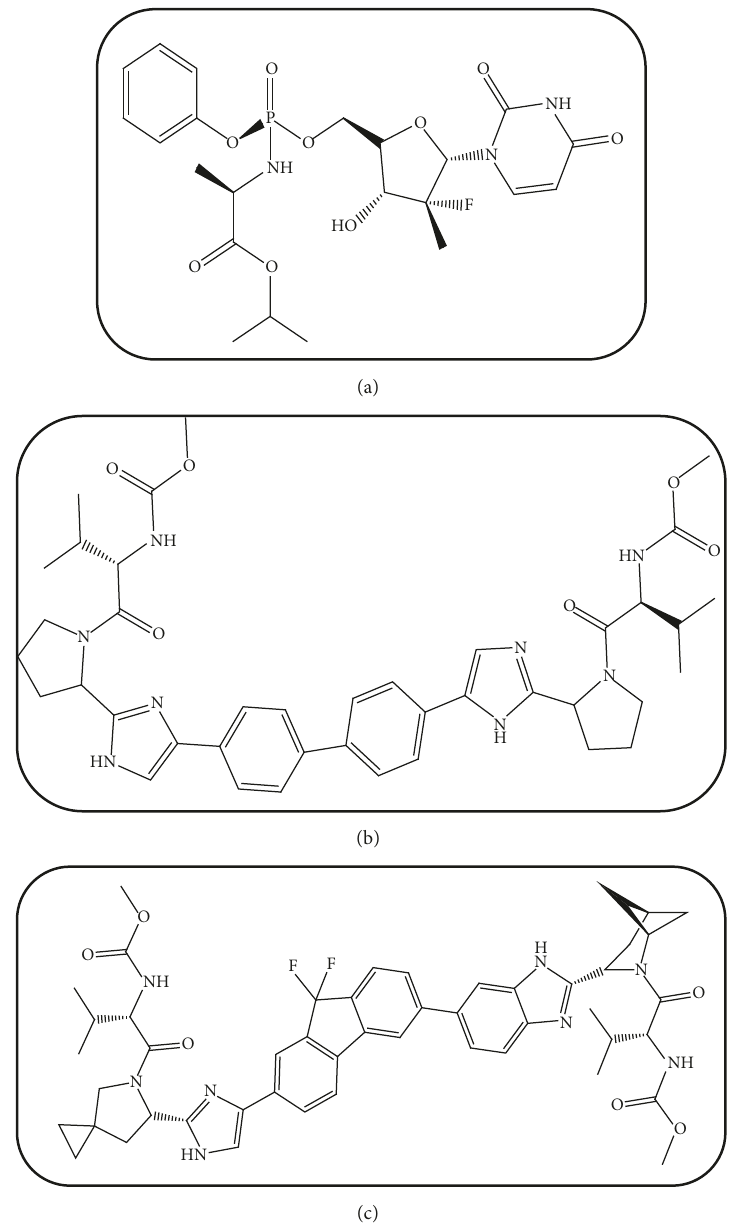
Figure 1: Chemical structure of SF (a), DC (b), and IS